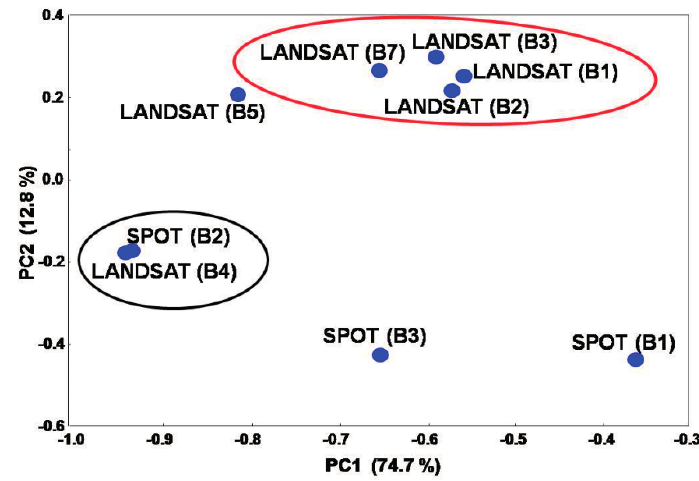
Figure 7. Representation of the satellite spectral bands (variables) in the reduced bi-dimensional principal factor space. Highly correlated spectral bands are highlighted in